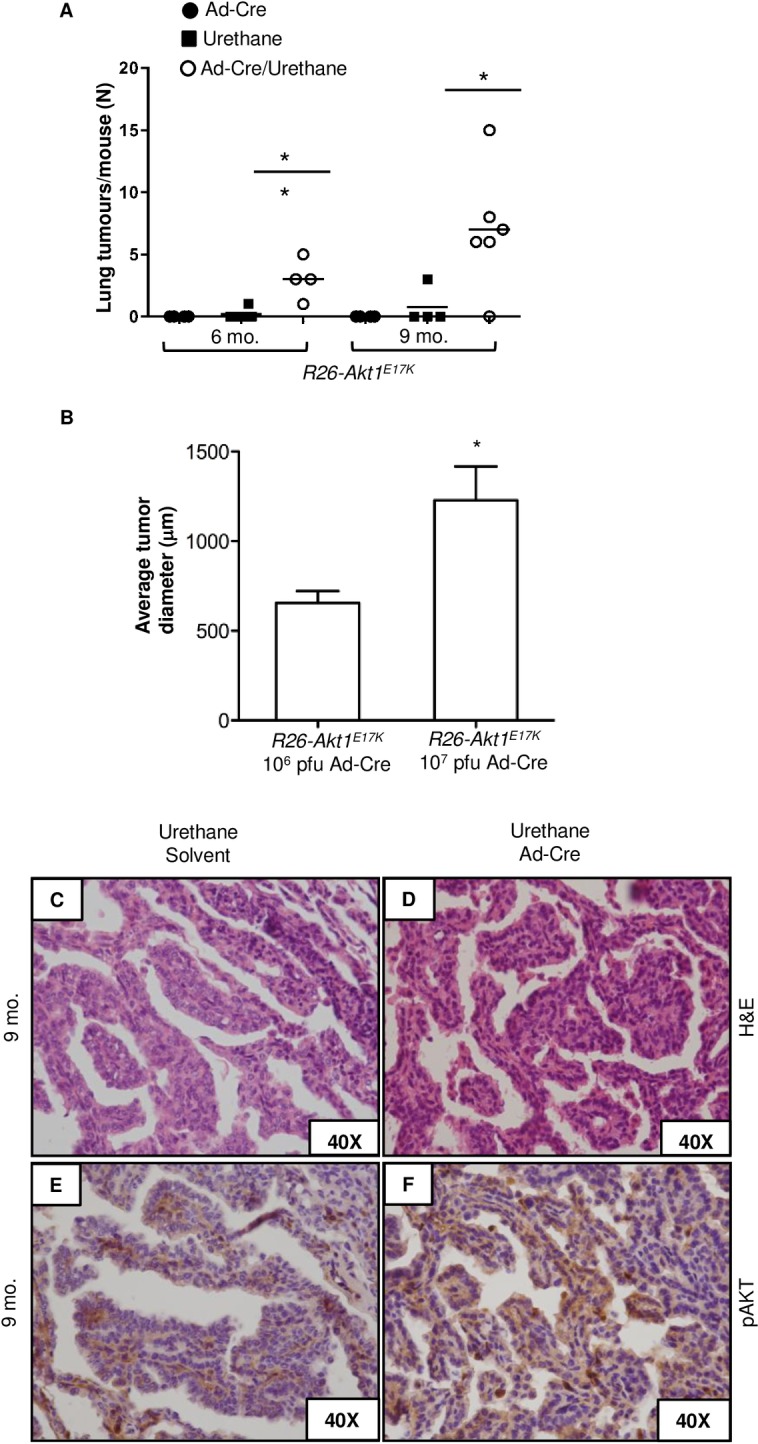
Mutant AKT1E17K accelerates tumor formation induced by chemical carcinogens.A. Lung tumor multiplicity in R26-AKT1E17K infected with Ad-Cre (6 and 9 months after the treatment, respectively). Each point represents one mouse; bars represent means ± SD. **p<0.01, *p<0.05. B. Diameter of lung tumors generated by urethane in R26-AKT1E17K mice treated with increasing doses of Ad-Cre. Bars represent mean diameter of tumor ±SD. *p<0.05. C, D. Representative H&E staining of lung lesions developed in R26-AKT1E17K mice treated with solvent or Ad-Cre, as indicated, 9 months after urethane administration. E, F. Phosporylated AKT staining of lung lesions developed in R26-AKT1E17K mice treated with solvent or Ad-Cre, as indicated, 9 months after urethane administration. Magnification as indicated.